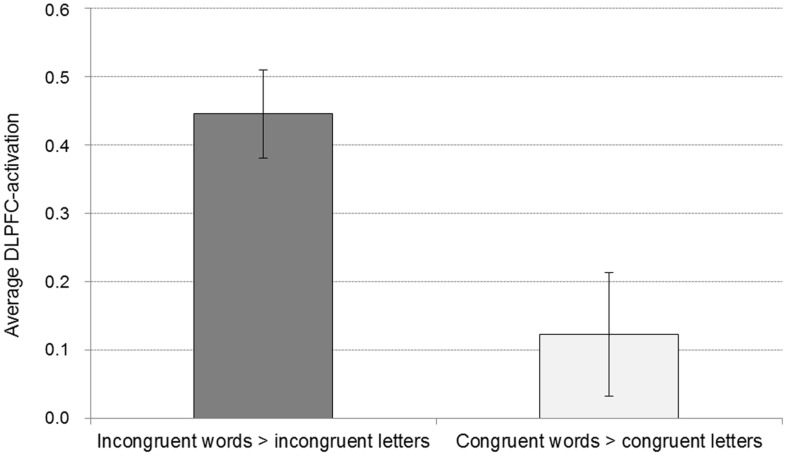
Average activation for the word conditions in comparison to the respective control conditions of the DLPFC peak voxel of the contrast incongruent words > incongruent letters (with a sphere of 8 mm). Displayed are means and standard errors.